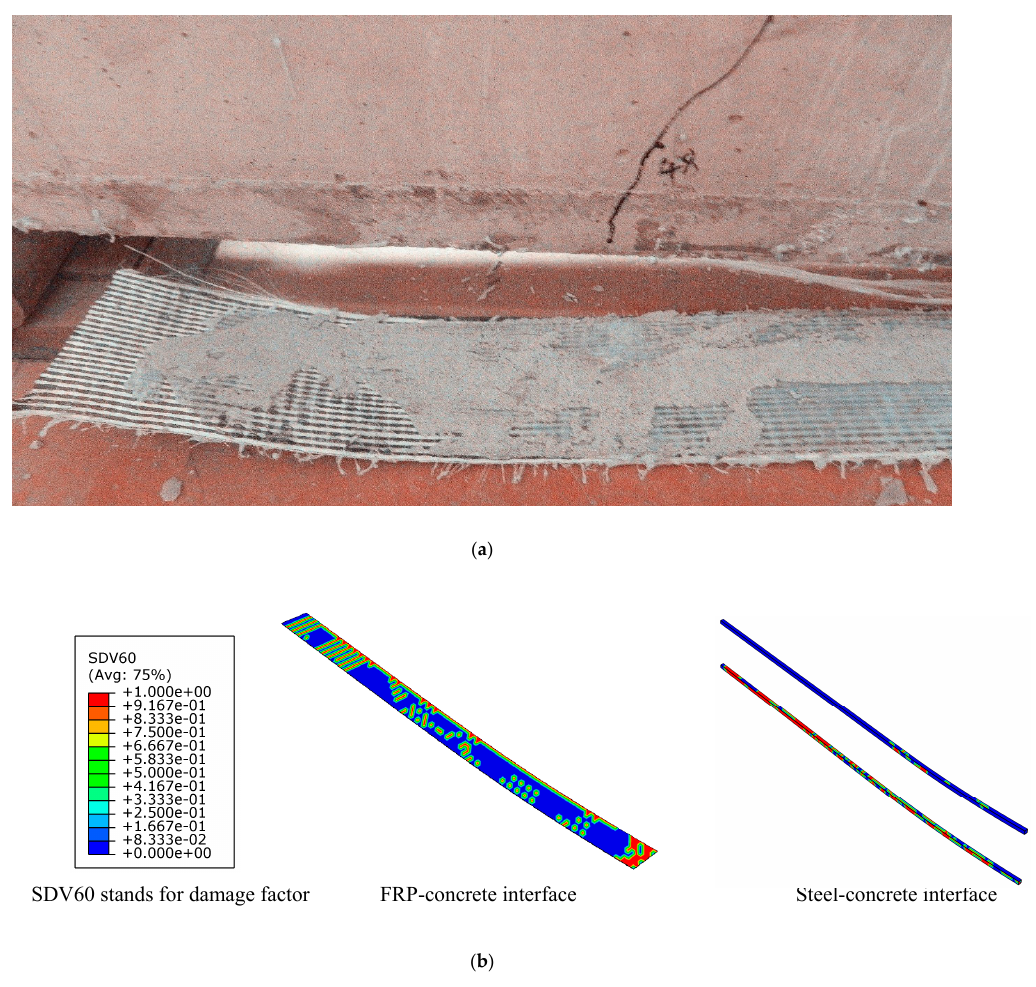
Figure 18. Debonding of the interface under the ultimate load of the beam strengthened with CG11 at prestress level 0.3: ( a ) debonding of the FRP-concrete interface in the test; ( b ) debonding of the interface in numerical simulation.